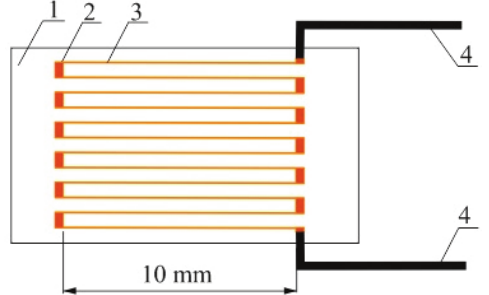
Fig. 5. Electrical resistant strain gauge; 1 – bed, 2 – borders of measurement base, 3 – resistant wire, 4 – power wires